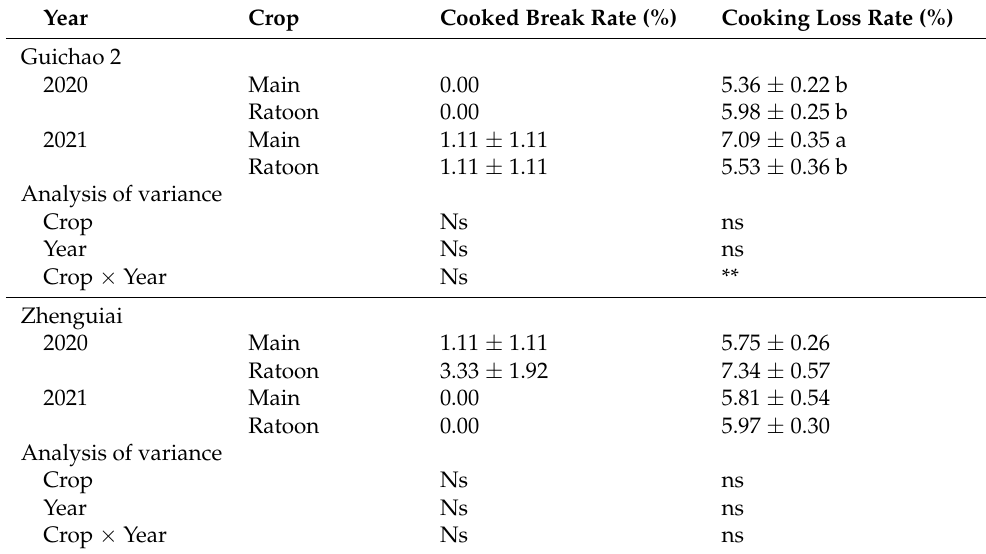
Table 2. Cooked break rate and cooking loss rate of noodles processed from rice grains of main and ratoon crops of two cultivars, Guichao 2 and Zhenguiai, grown in 2020 and 2021. Year Crop Cooked Break Rate (%) Cooking Loss Rate (%) Guichao